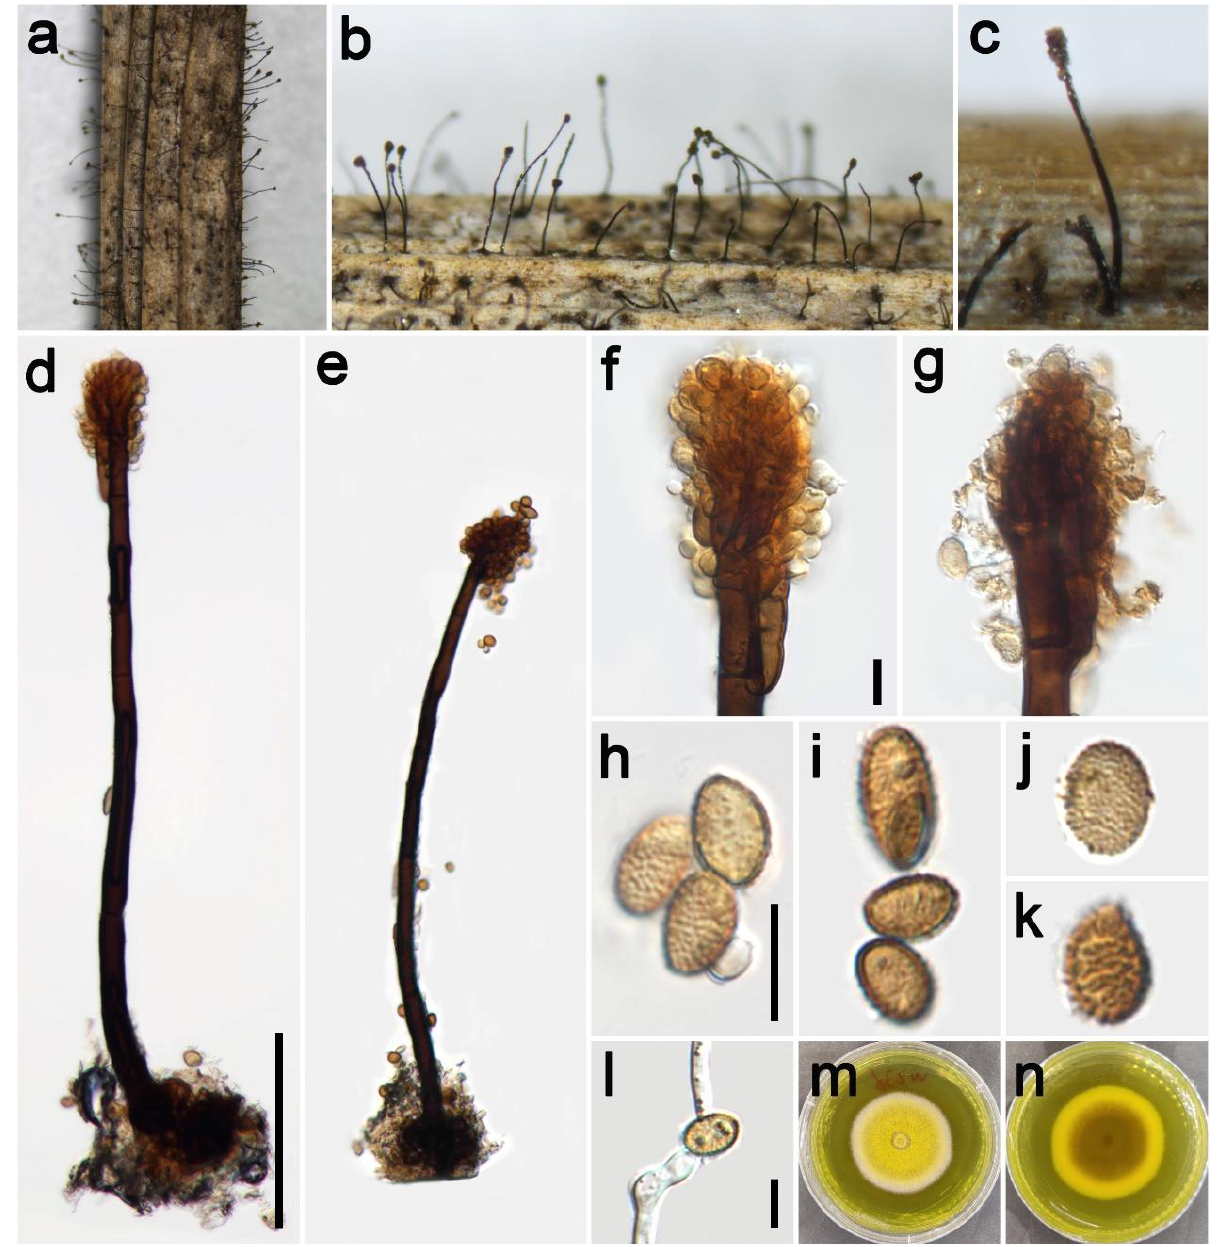
Figure 8. Periconia imperatae (HKAS 126517, holotype). ( a – c ) Colonies on the natural substrate; ( d , e ) conidiophores with spherical conidial heads; ( f , g ) apically branch conidiophores with conidial head; ( h – k ) conidia; ( l ) germinating conidium; ( m , n ) colony on PDA from above and below. Scale bars: ( d ) = 100 µm, ( f , h , l ) = 10 µm. Scale bar of ( d ) applies to ( e ). Scale bar of ( f ) applies to ( g ). Scale bar of ( h ) applies to ( i – k ).